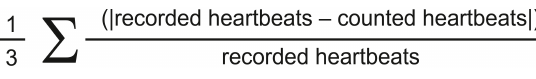
FIGURE 2 | Formula used to calculate the heartbeat detection